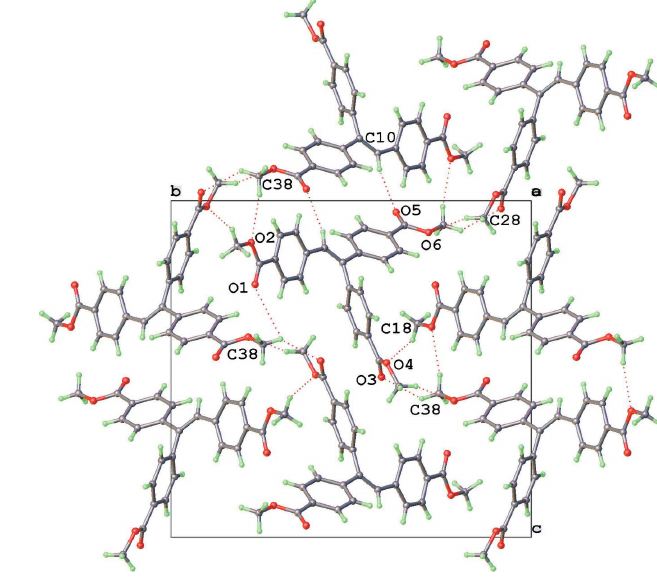
Figure 1 A view of the molecular structure of (I). Displacement ellipsoids are drawn at the 40% probability level.